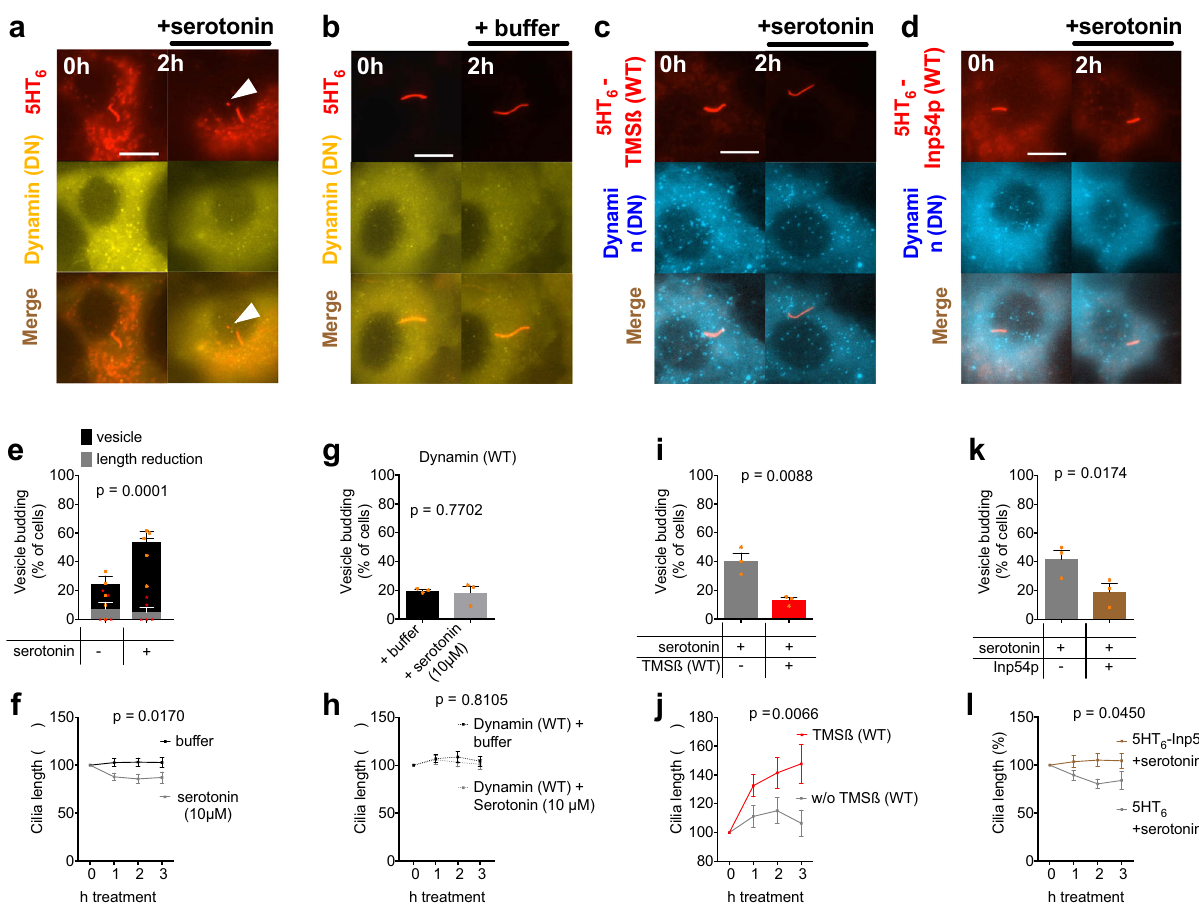
Fig. 4 Agonist-induced vesicle secretion requires PIP 2 and polymerised actin. a , b Time-lapse images of a NIH3T3 cells expressing the ciliary marker 5HT 6 -mCherry and in addition GFP-Dynamin2 (DN) to inhibit 5HT 6 endocytosis. Images were acquired 0 and 2 h after adding serotonin (10 µ M fi nal) ( a ) or buffer ( b ). White arrowheads mark ciliary vesicles. Scale bar 10 µ m. c , d Images of cells expressing 5HT 6 -mCherry-TMSß ( c ), respectively, 5HT 6 - mCherry-Inp54p (WT) ( d ) and in addition CFP-tagged DN Dynamin2. Images were acquired 0 and 2 h after adding serotonin (10 µ M fi nal). e Frequency of ciliary vesicle budding in n = 5 independent experiments with cells treated as in ( a ) and ( b ), two-way ANOVA. Orange asterisks indicate individual data points for appearance of a vesicle, red asterisks indicate individual data points for length reduction. f Normalized cilium length in the same n = 46 and n = 61 cells as in ( e ), p -value is interaction from two-way ANOVA. g Frequency of ciliary vesicle budding in n = 3 independent experiments with cells treated as in ( a ) but with WT Dynamin instead of DN Dynamin, t -test. h Normalized cilium length in the same n = 45 and n = 47 cells as in ( g ), p -value is interaction from two-way ANOVA. i Frequency of ciliary vesicle budding in n = 3 independent experiments with cells treated as in ( a ), ( c ), t -test. j Normalized cilium length in the same n = 47 and n = 38 cells as in ( i ), two-way ANOVA. k Frequency of ciliary fi ssion in n = 3 independent experiments with cells treated as in ( a ), ( d ), t -test. l Normalized cilium length in the same n = 39 and n = 37 cells as in ( k ), two-way